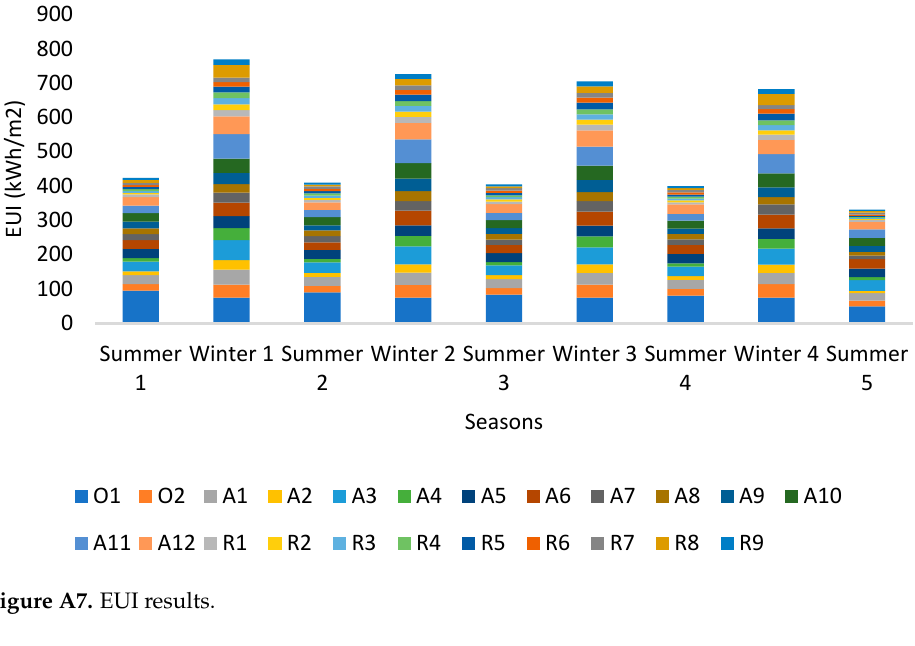
Figure A7. EUI results.